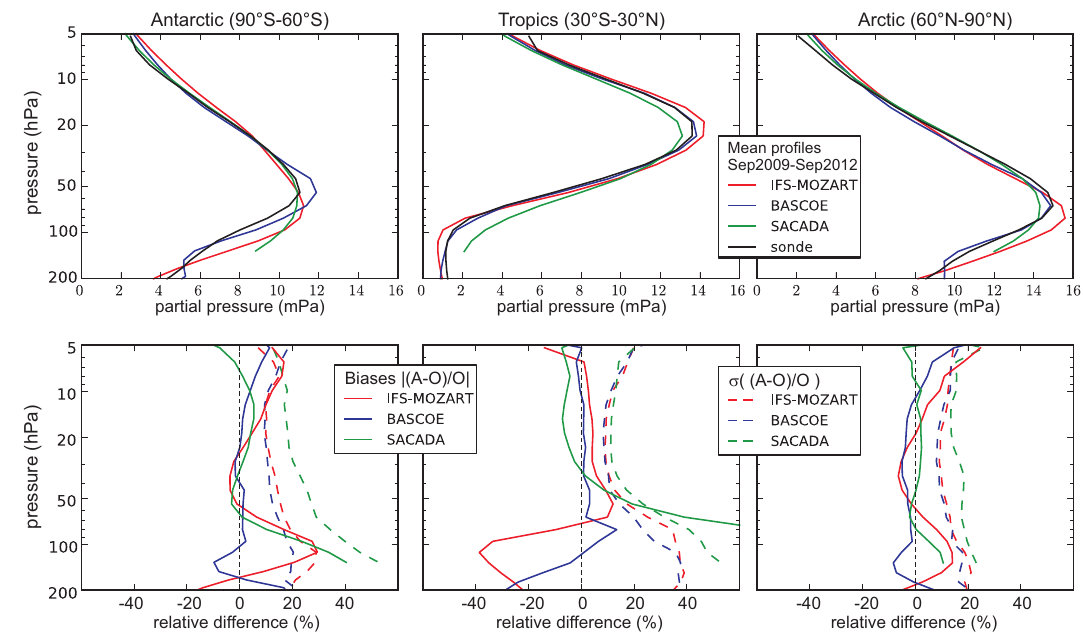
Figure 4. Top row: mean ozone profiles (top rows) as partial pressures in mPa from IFS-MOZART (red), BASCOE (blue), SACADA (green) and ozonesondes (black). Bottom row: mean and (solid lines) and standard deviations (dashed lines) of the relative differences, in %, of these analyses against the ozonesondes. over the period from September 2009 to September